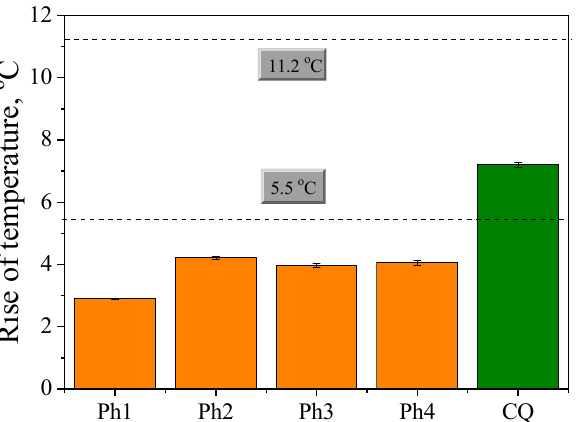
Figure 3. The mean values with a standard deviation of the maximum temperature increase during irradiation of the tested polymeric materials. The photoinitiating systems contain different light absorbers marked in Figure and the same co-initiator (phenylthio)acetic acid (PhTAA) and the dental filler DF3 (i-FIX LC Light Curing Glass Ionomer Filling Cement). The light intensity of the dental lamp was 15 mW/cm 2 . The dashed lines in Figures 3 and S3 indicate the two pulp temperature tolerance thresholds. The first limit represents a temperature increase of 5.5 ◦ C [53,55,56]. This